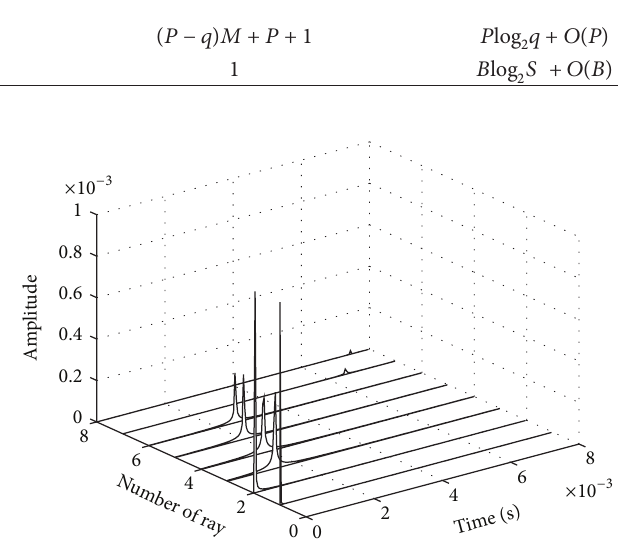
Figure 1: Impulse response of channel used in this paper.